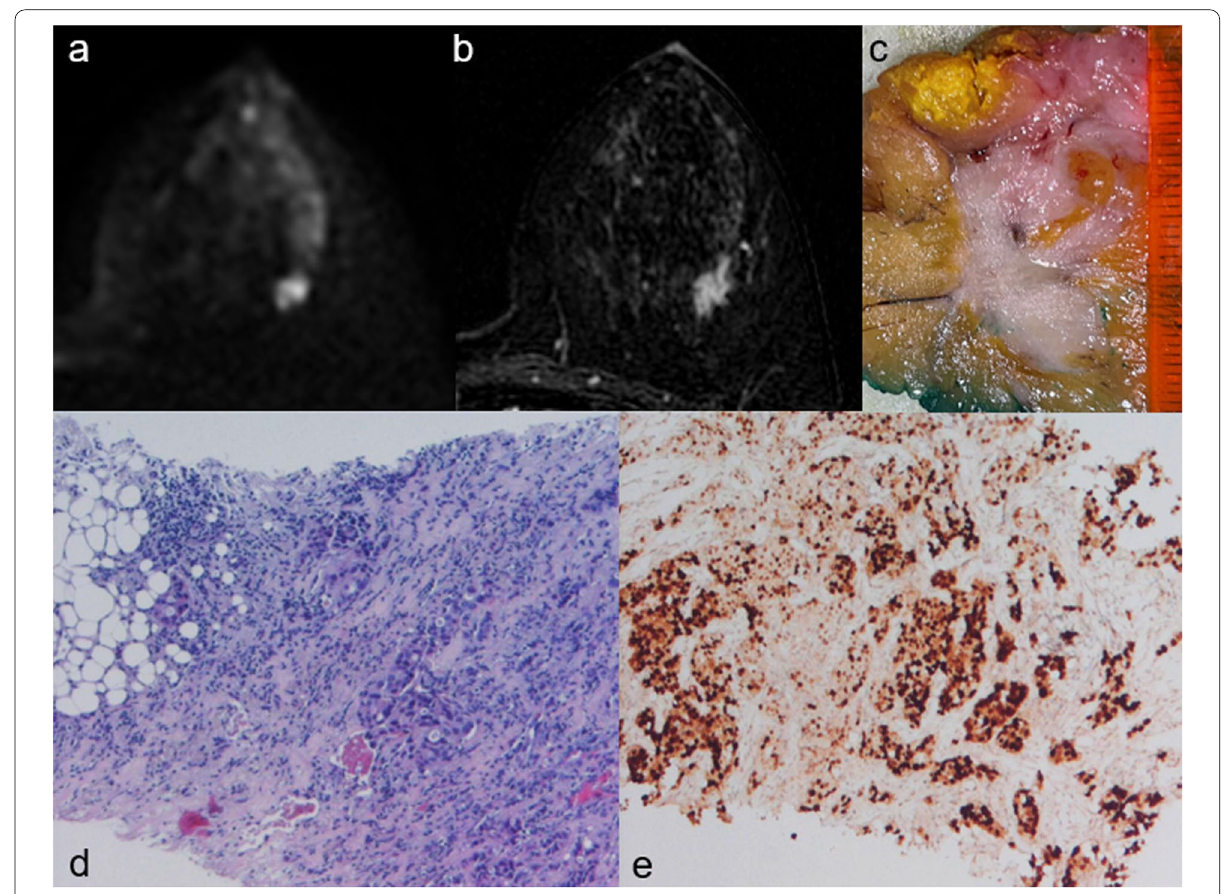
Fig. 3 A 42-year-old woman with a luminal A-like carcinoma in the outer upper quadrant of the left breast. a Axial diffusion-weighted image ( b -value 1,000 s/mm. 2 ) shows the high signal intensity of the mass, corresponding to a restricted diffusion area. b Axial post-contrast T1-weighted = subtracted image shows a 14-mm mass with irregular shape, spiculated margins, and heterogeneous enhancement. c On cut surface, the lesion has irregular and infiltrative borders. d – e Histologic examination confirms the diagnosis of infiltrating carcinoma of “no special type” with diffuse expression of oestrogen receptor on